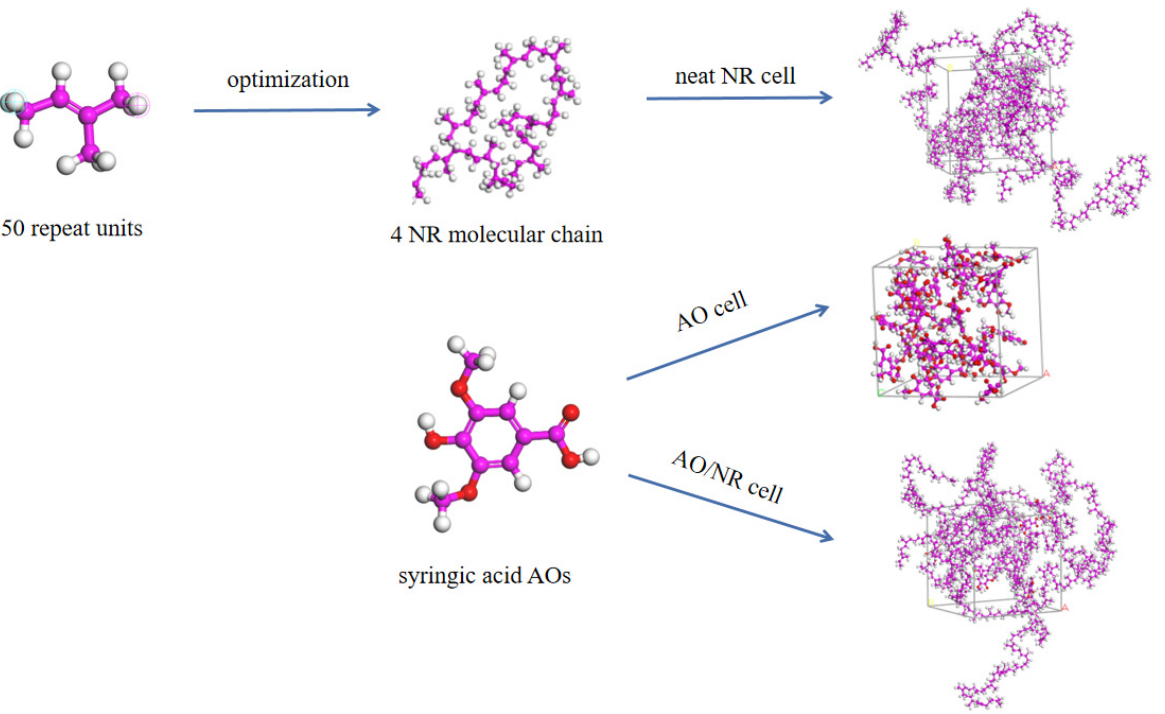
Figure 3. Construction processes of three types of amorphous cells (take syringic acid, for example, and the purple, white, and red spheres represent C atoms, H atoms, and O atoms, respectively).